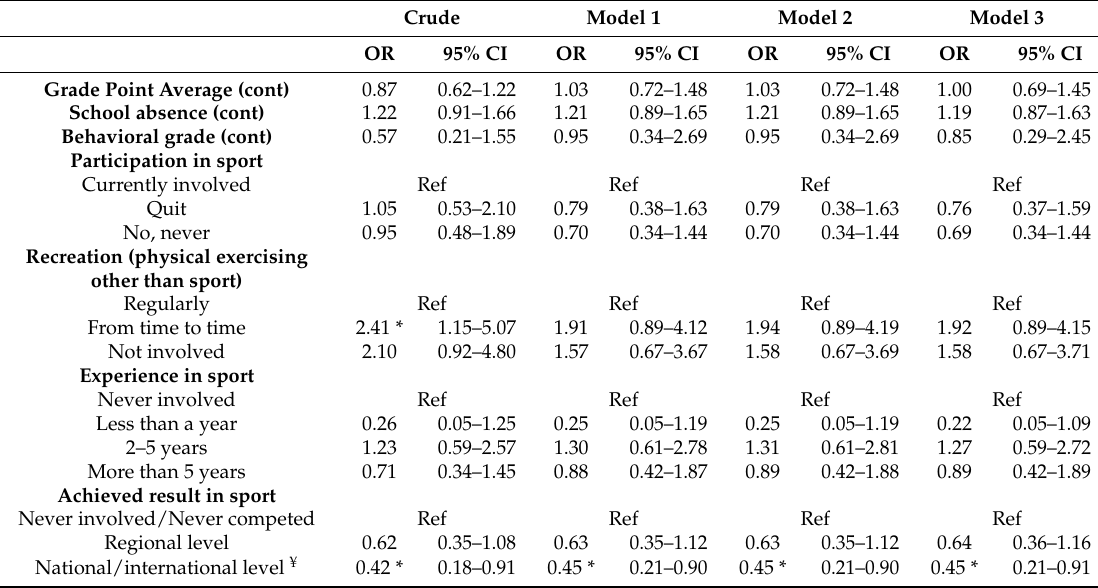
Table 2. Correlates of smoking initiation for 47 participants who initiated smoking during the course of the study (12% of 379 adolescents who did not smoke at study